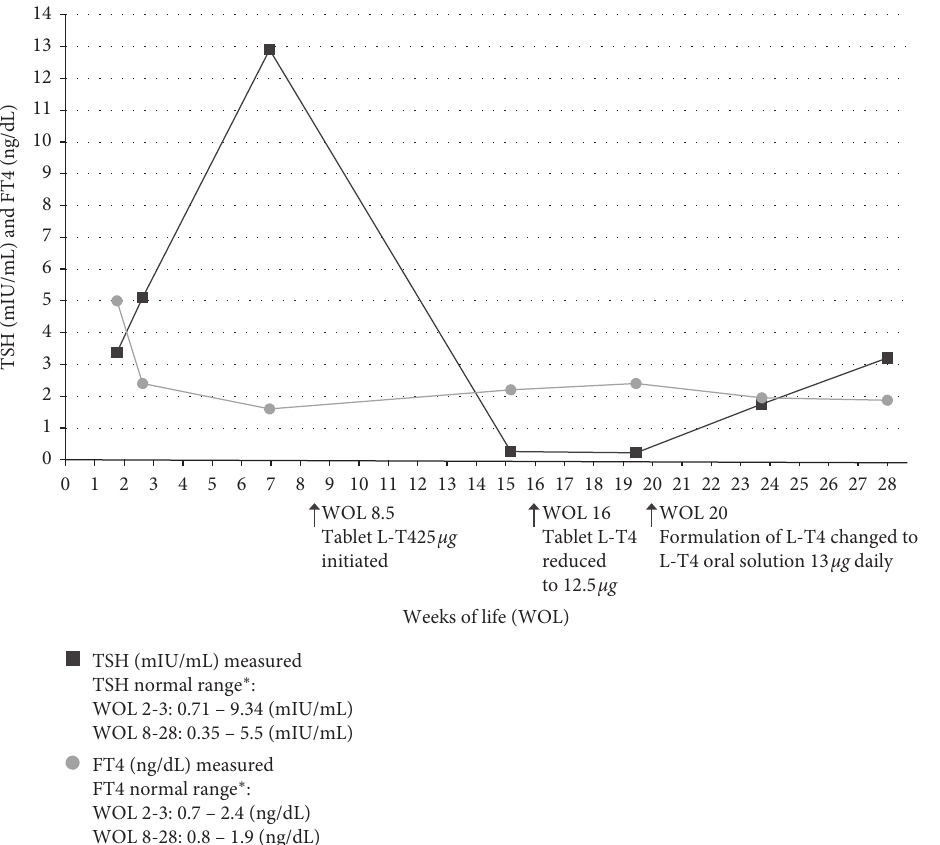
Figure 1: Thyroid-stimulating hormone (TSH) and free thyroxine (FT4) timeline. ∗ Normal ranges shown are those used by the author’s institution. L-T4, levothyroxine sodium oral solution; WOL, weeks of life.